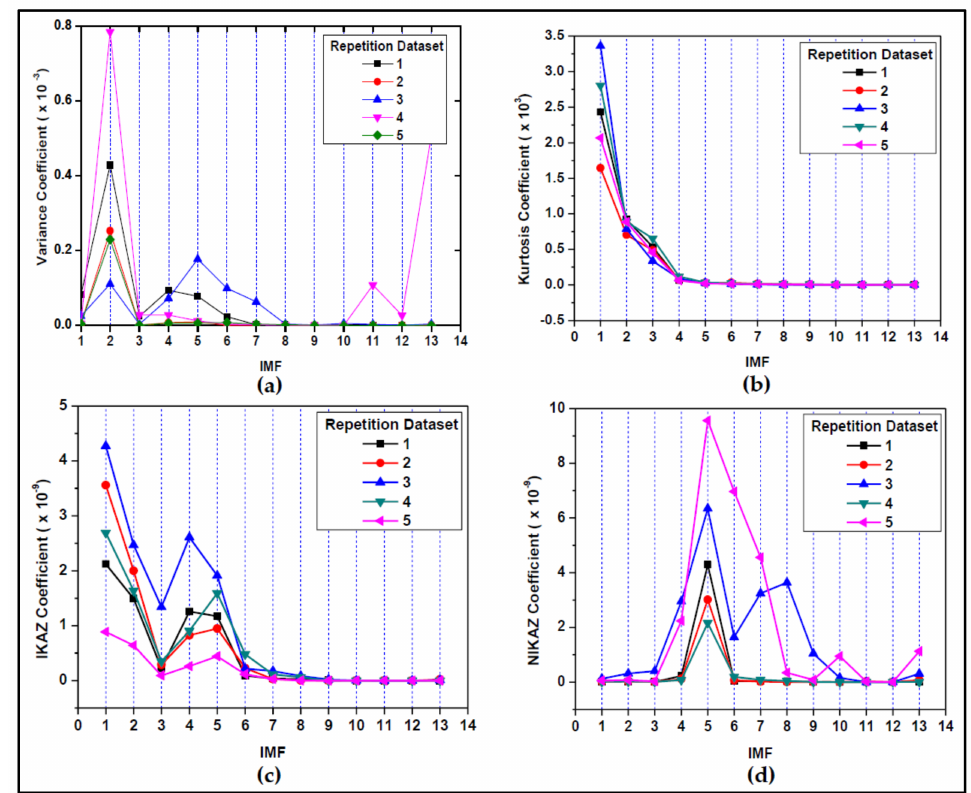
Figure 12. The curve for 1 mm leak IMFs with 4 bar pressurised pipe: ( a ) Variance, ( b ) Kurtosis, ( c ) IKAZ, ( d )